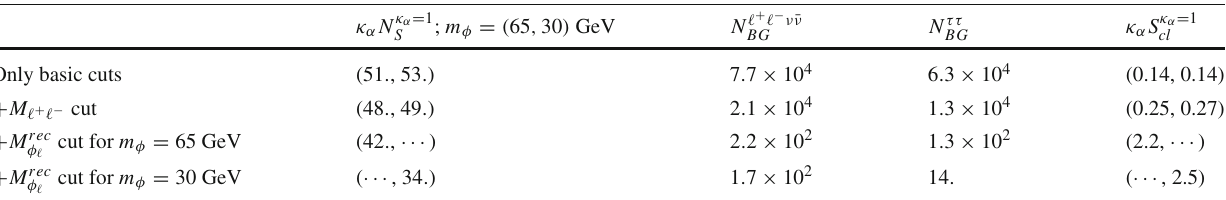
nosity is taken as 900 fb − 1 , and N S ( S cl ) is given by the products of scaling factor k α and the value for κ α =